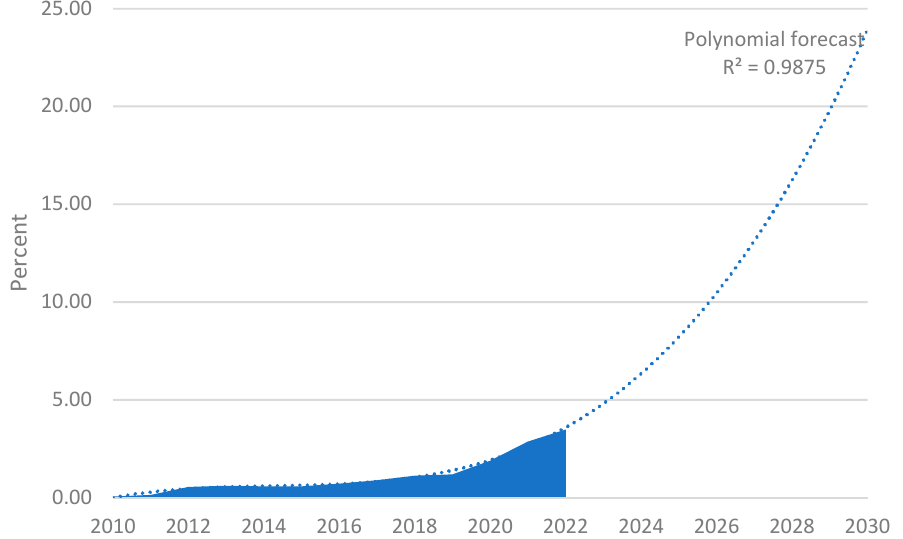
Figure 5. Percent share of BEVs and PHEVs in the LCVs market in the EU. Source: EAFO [89].